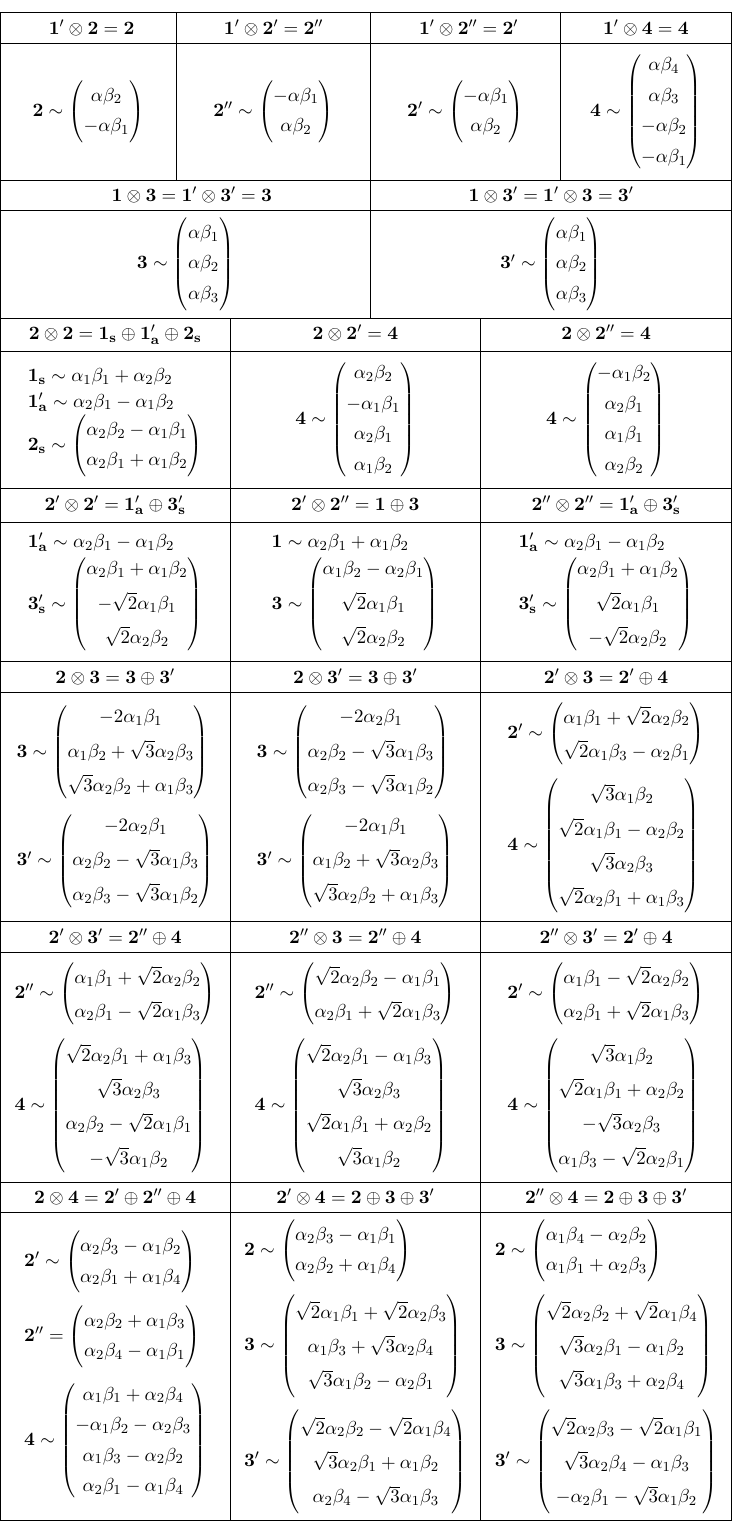
Table 5 . Multiplication rules of different irreducible representations of GL(2 , 3) and the corre- sponding Clebsch-Gordan